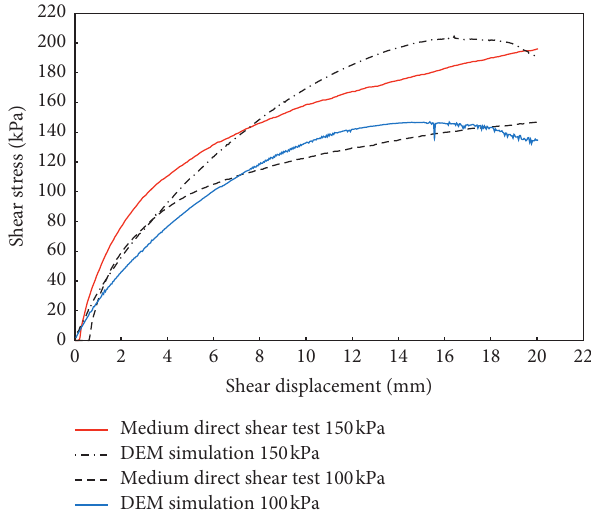
Figure 6: Fitting curves of shear test and discrete element nu- merical test.